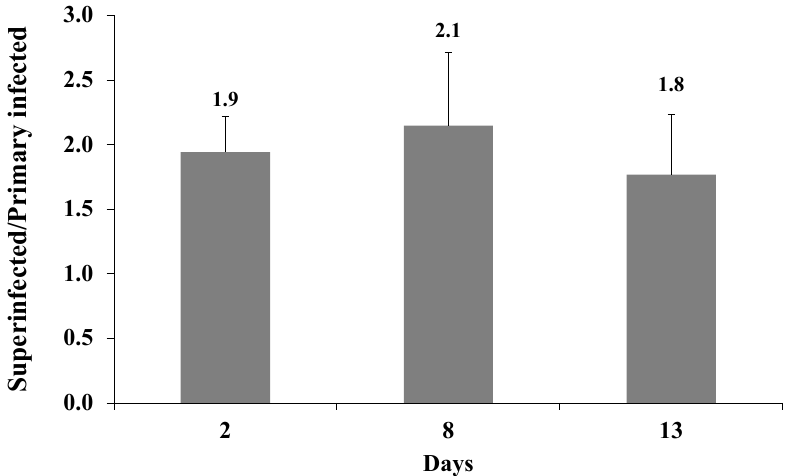
Figure 6. Enhanced expression of the fluorescent marker of the incoming virions in superinfected iSLK cells is maintained over time. iSLK and BAC16-mCherry or BAC16-mNeonGreen iSLK-infected cells were infected as described in Figure 2. After two, eight, and 13 d, the cells were harvested, and the percentage of cells expressing the fluorescent marker gene of the incoming virions was measured by FACS. The graph shows the ratios between the percentage of cells expressing the incoming virions fluorescent protein in superinfected and primary infected cells. Results are from three independent experiments. Statistical analysis was performed using a one-way ANOVA test, and showed no significant differences between the ratios over time.